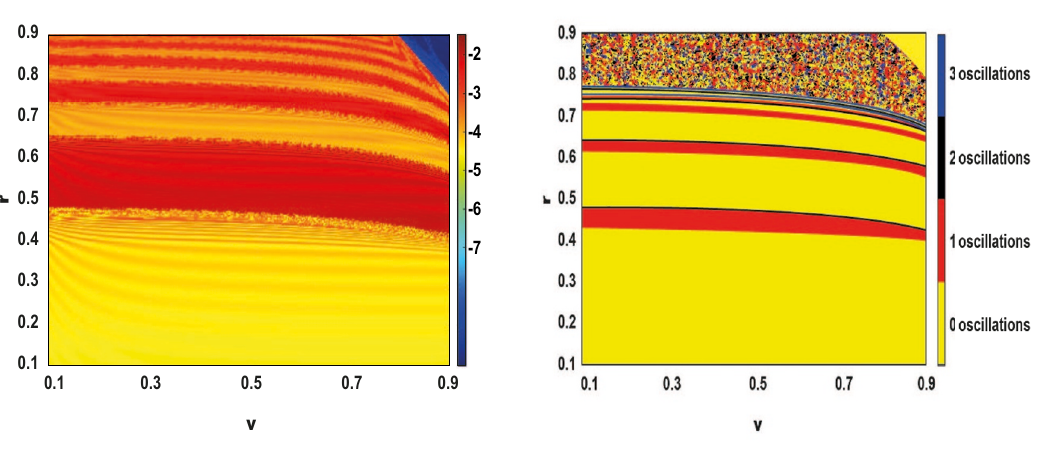
Figure 9 . Output of the large kink-antikink collision process: a) (left) The final state of the scalar field φ (0 , t f ), with t f = x 0 /v + 100, b) (right) number of solitary